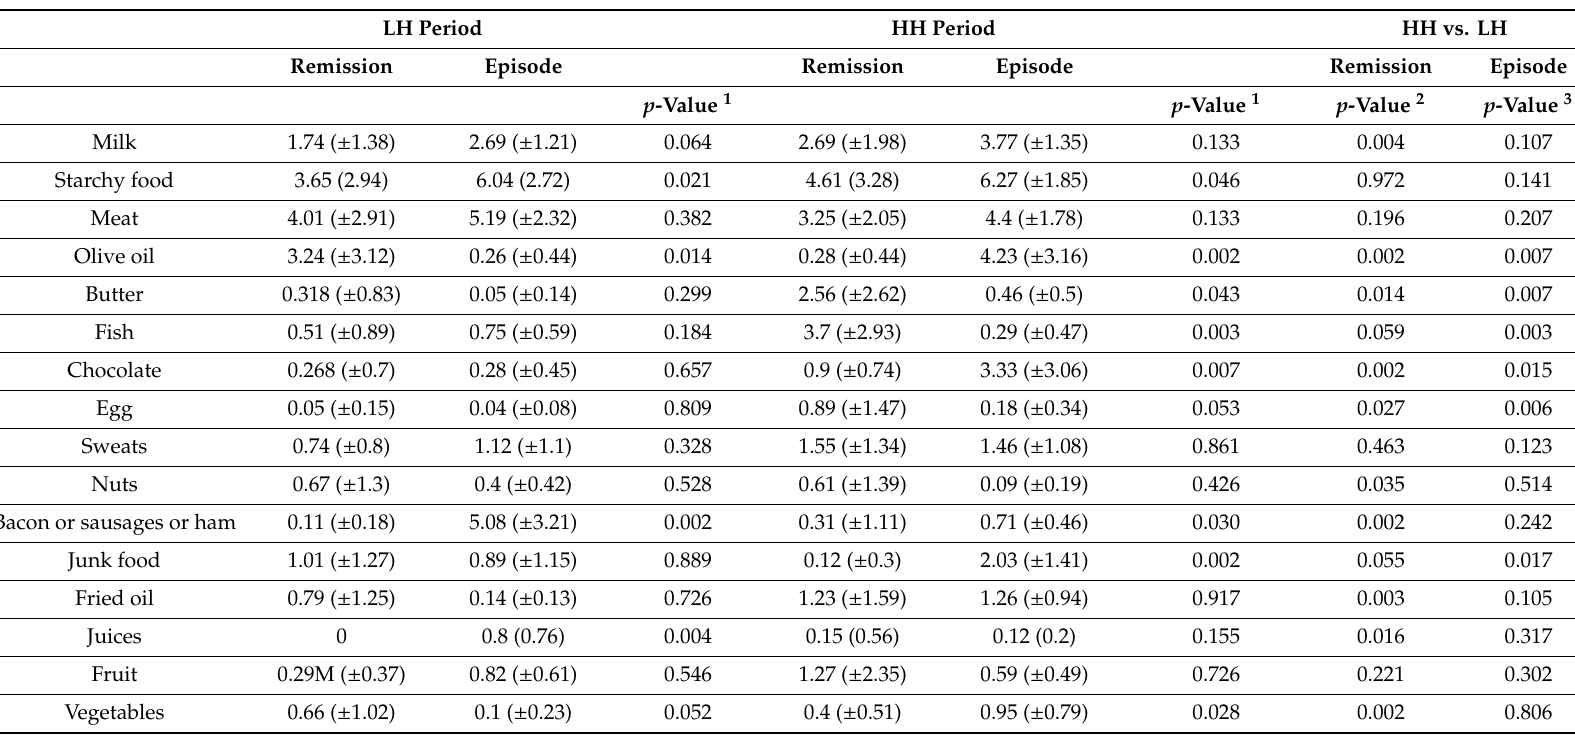
Table 4. Changes in the frequency of consumption of di ff erent foods (food choices) according to symptom fluctuation during and among the two intervention